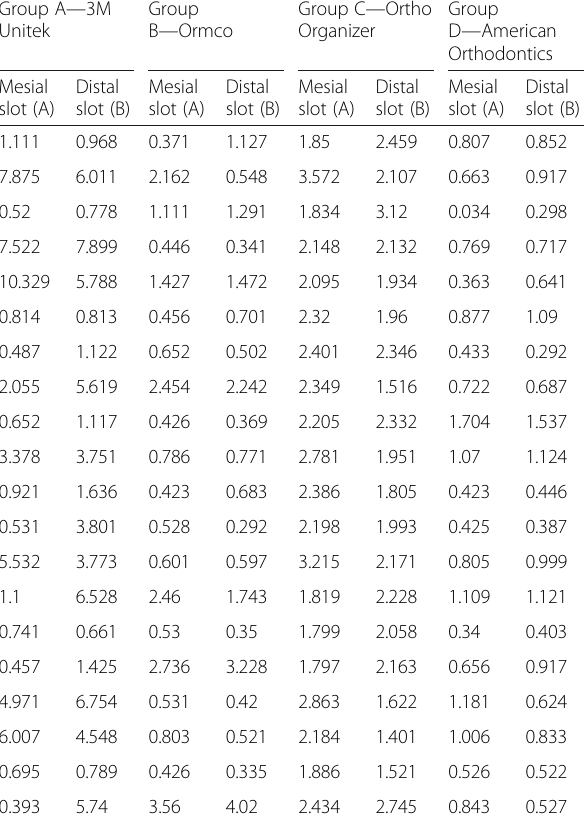
Table 3 Average surface roughness (Sa values) of bracket slot (measurement in micrometre) Group A — 3M Unitek